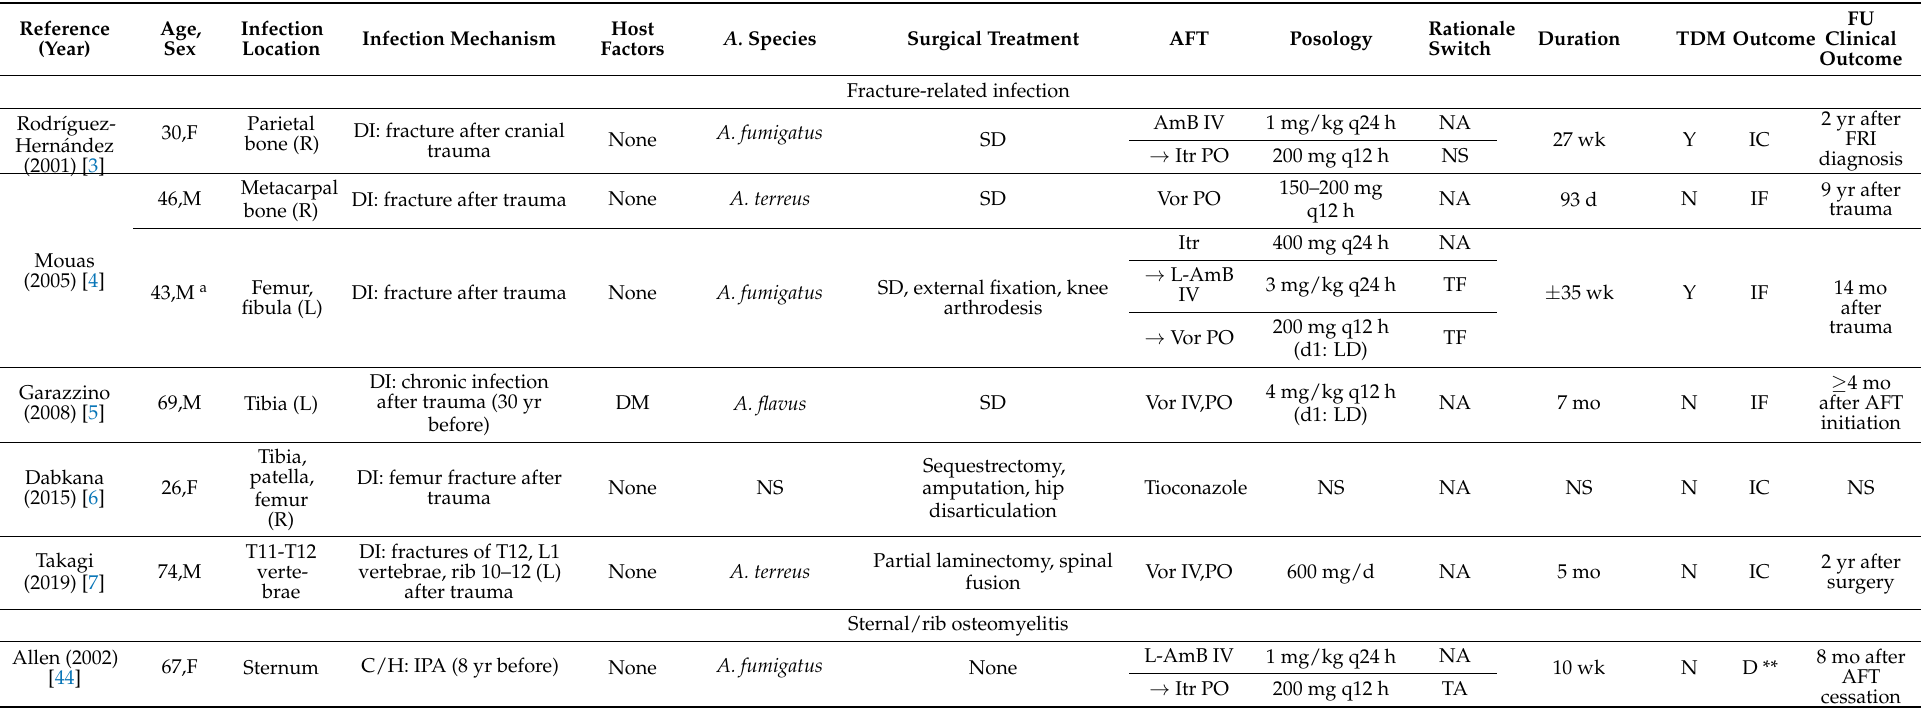
Table A1. Demographic, clinical and therapeutic characteristics of Aspergillus osteomyelitis and spondylodiscitis cases ( n =